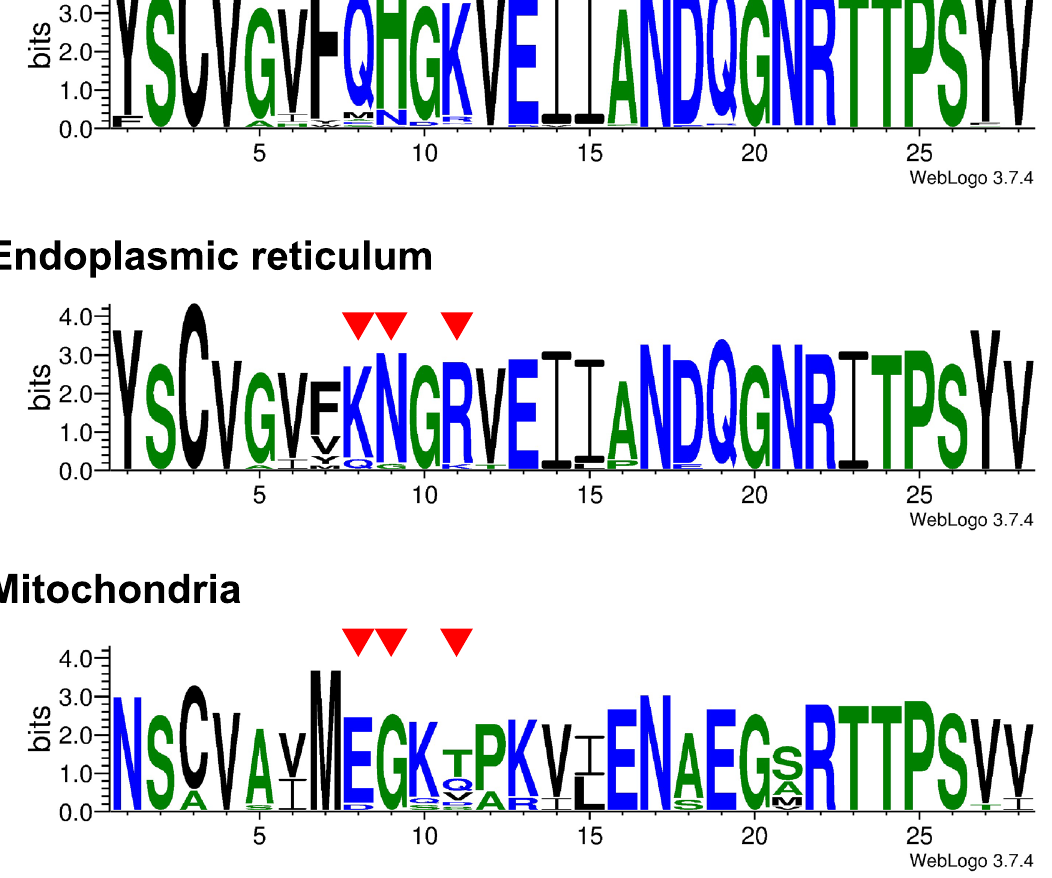
Figure 2. Logo visualization of cytosol-, endoplasmic reticulum (ER)-, and mitochondria-specific sequences near the N terminus of the HSP70 family members. All sequences in Fig. 1 were used to compute the sequence logos (93, 18, and 13 sequences for cytosol-, ER, and mitochondria-specific members, respectively). Compared to the cytosolic form, ER-specific forms have several conserved amino acid substitutions: Q8K, H9N, K11R, and T23I. Similarly, mitochondrial forms have Y1N, G5A, F7M, Q8E, H9G, G10K, K11T/Q/V, V12P/A, E13K/R, I14V, I15L, A16E, D17A, Q18E, and N21S/A/M. Residues that can be useful for discriminating organelle- specific members are shown with red arrows. Position 23 also discriminates ER-specific members from